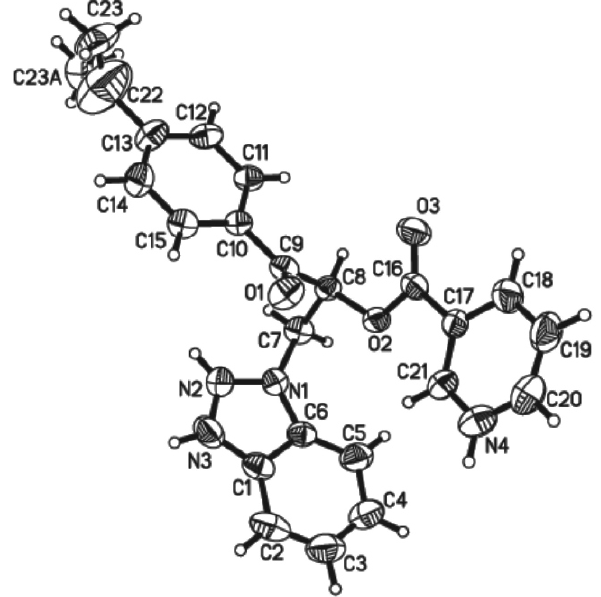
Table 1. Data collection and handling.